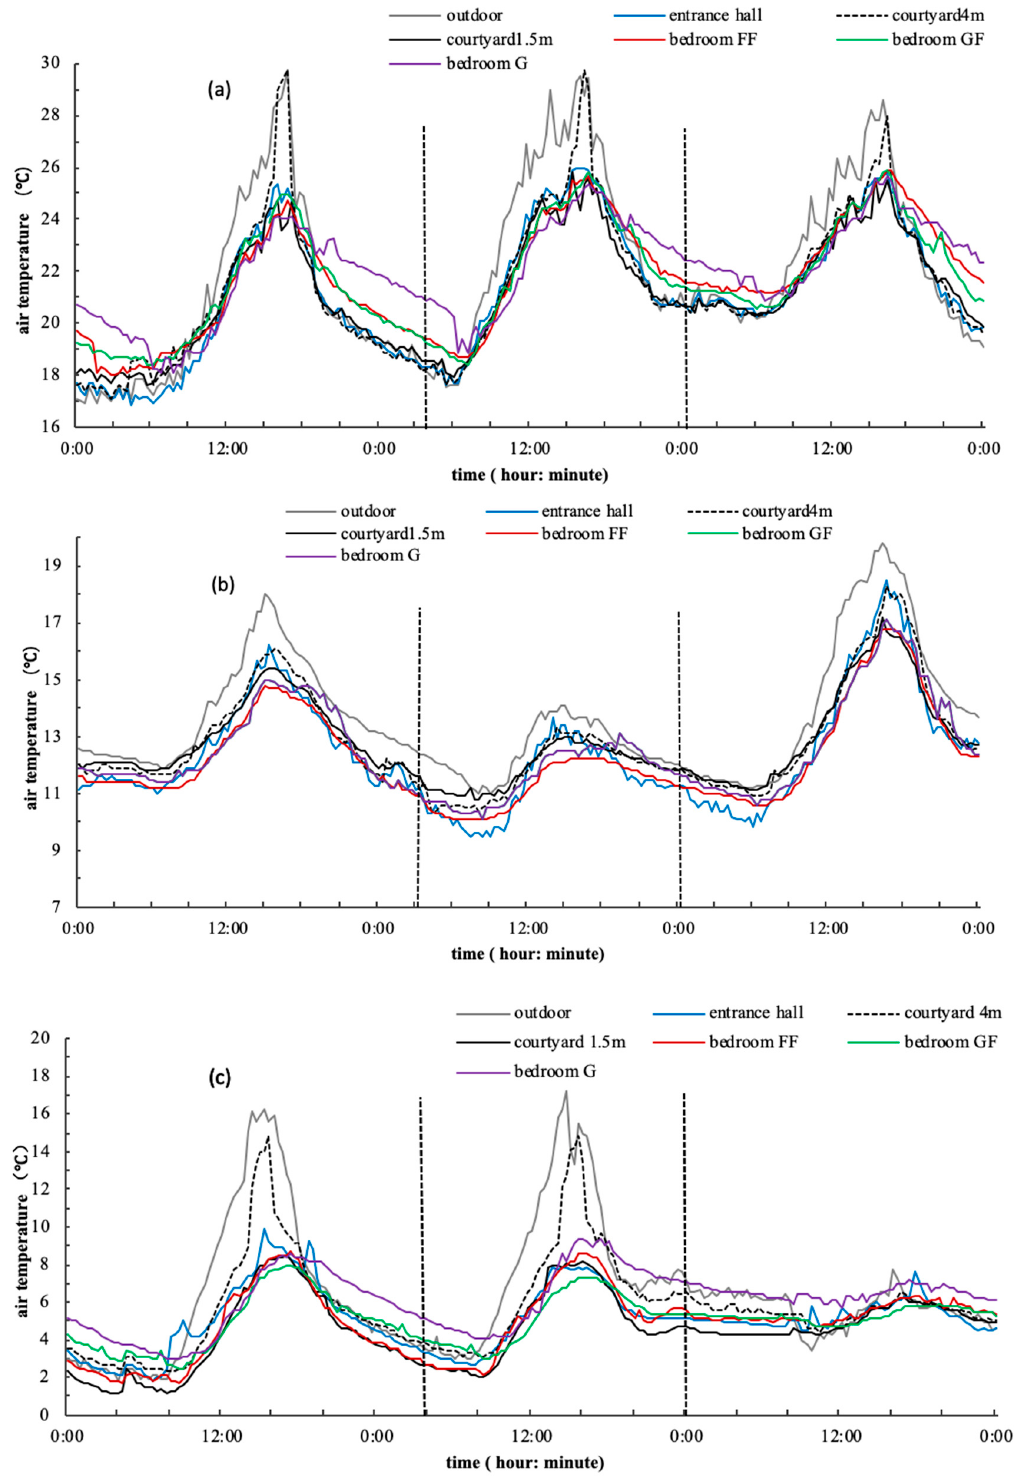
Figure 15. Air temperature distributions from: ( a ) 22–28 August 2011 (summer); ( b ) 12–20 April 2012 (transition season); and ( c ) 26–28 January 2013 (winter). Bedroom FF represents measuring point H and bedroom GF represents measuring point E.